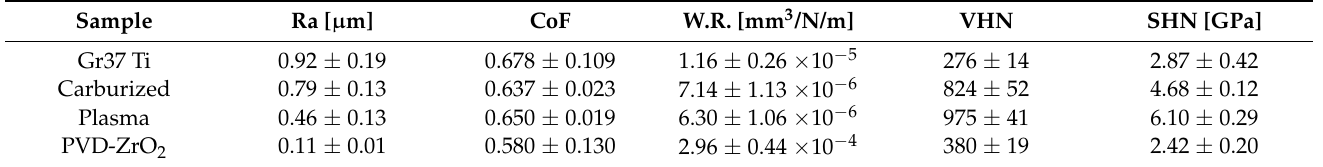
Table 2. Surface roughness (Ra), friction coefficient at 450 °C against alumina (CoF), wear rate at 450 °C in dry sliding against alumina pin (WR), Vickers Hardness Number (VHN) and Scratch Hardness Number (SHN) of Grade 37 Ti and surface-treated samples.